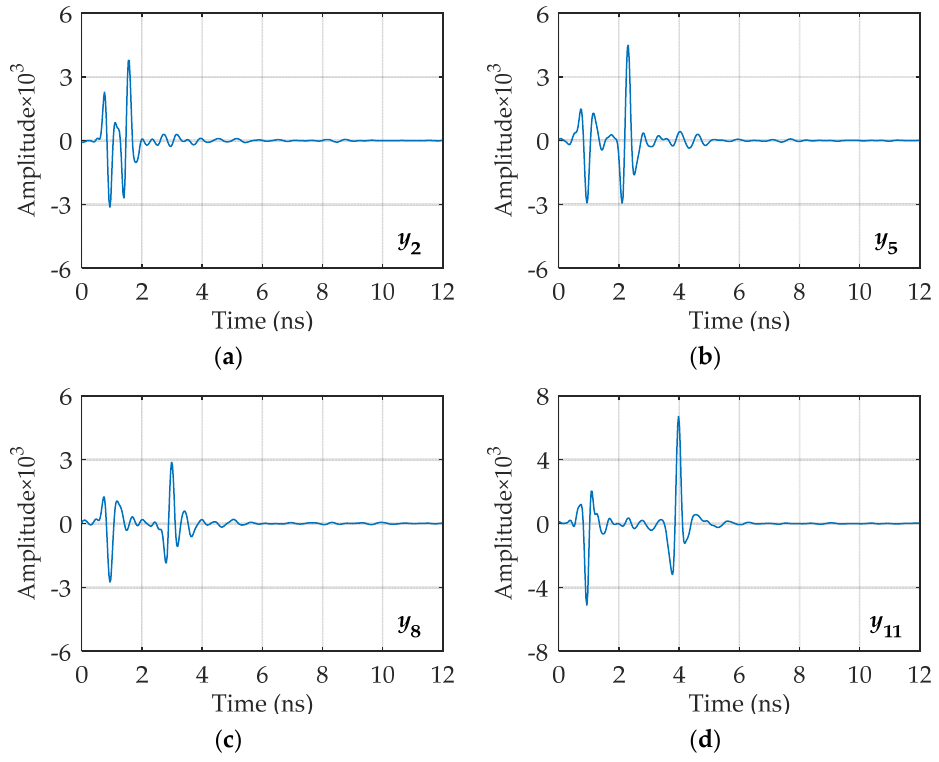
Figure 11. Different typical single-channel signals on the longitudinal survey line x 2 : ( a ) x 2 − 1 represents the signal of the 5 cm model box; ( b ) x 2 − 2 represents the signal of the 10 cm model box; ( c ) x 2 − 3 represents the signal of the 15 cm model box; ( d ) x 2 − 4 represents the signal of the 20 cm model box.